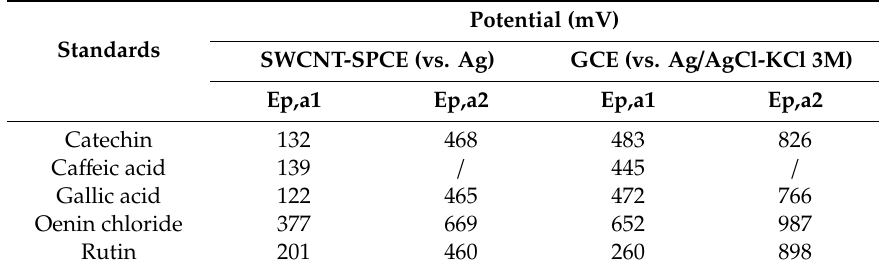
Table 2. Voltammetric behavior of the studied standard polyphenols in tartaric acid bu ff er (pH 3.6) with SWCNT-SPCE and GCE for a concentration of 0.1 mM.